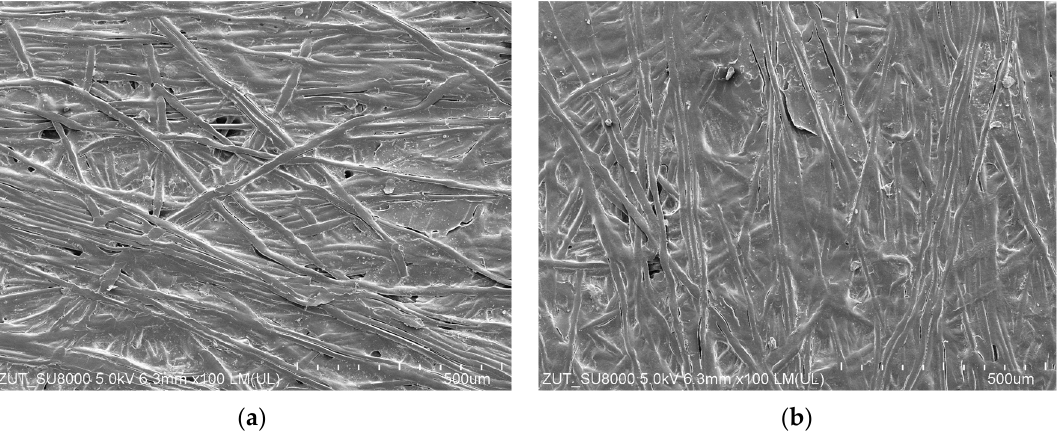
Figure 17. FESEM images of the membrane support surface: ( a ) Virgin UE50; ( b ) UE50 after separation of the blue+wax solution (Figure 12).